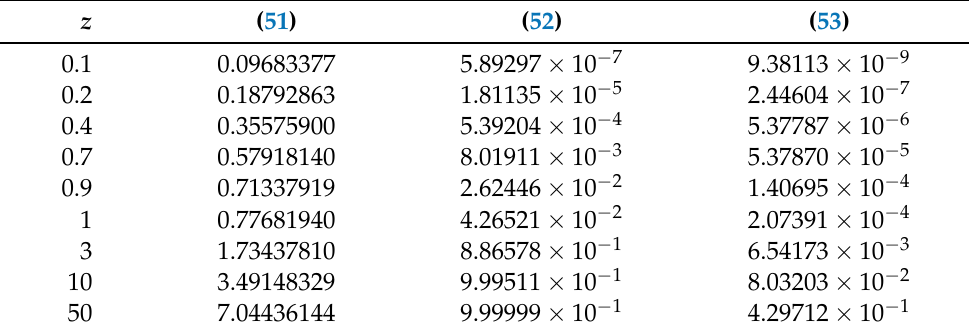
Table 3. Relative error of 5th partial sum and 5th approximant for arcsinh 2